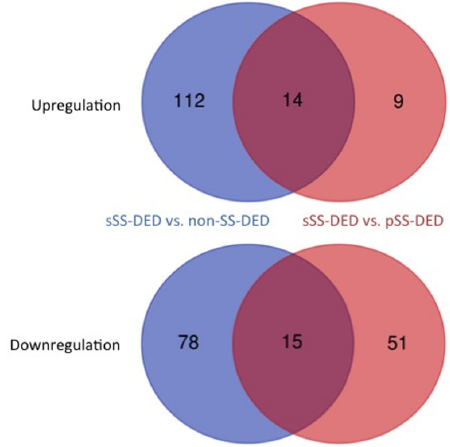
Figure 3. The candidate proteins were those overlapping with differentially expressed proteins in sSS-DED patients versus non-SS-DED and pSS-DED, respectively. Twenty-nine proteins (14 upregulated and 15 downregulated) were identified.